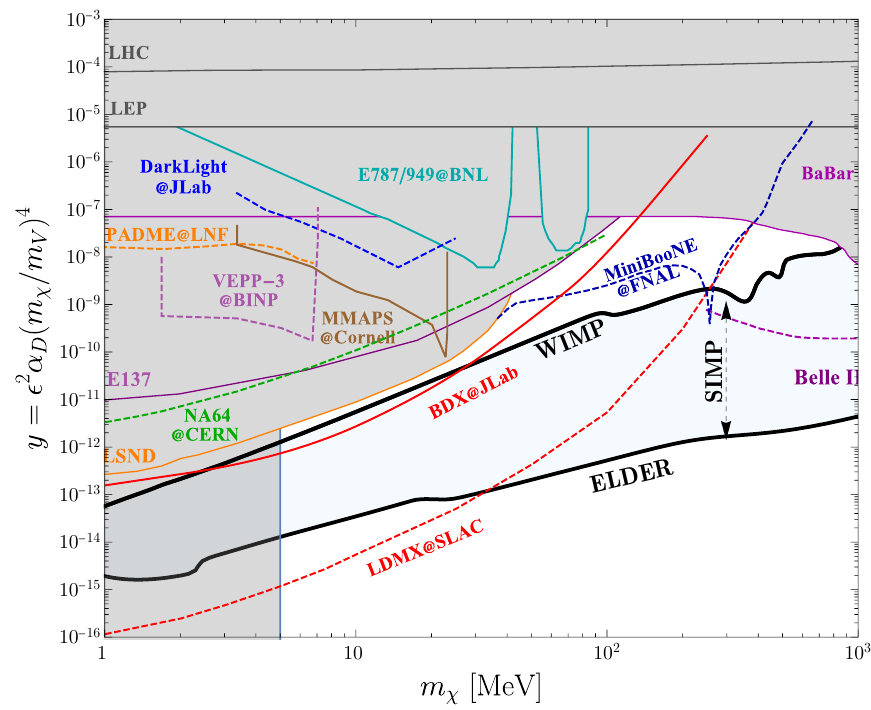
Figure 4 . The dark photon target region predicted in the ELDER, WIMP and SIMP scenarios. For comparison, the current bounds and projected sensitivities of searches for dark photon decaying to dark matter particles [28] are also